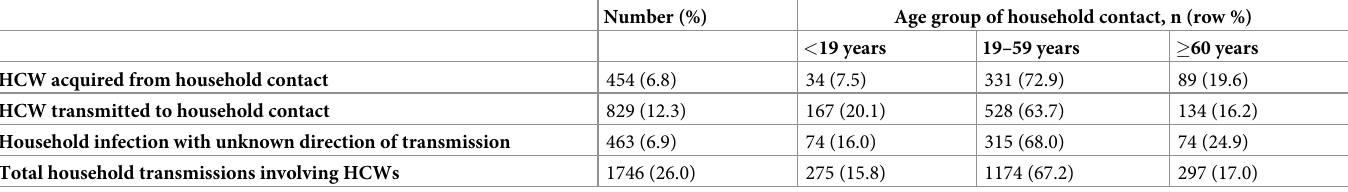
Table 3. Healthcare worker within household SARS-CoV-2 acquisitions and transmissions (n = 6,716 healthcare workers). Number (%) Age group of household contact, n (row